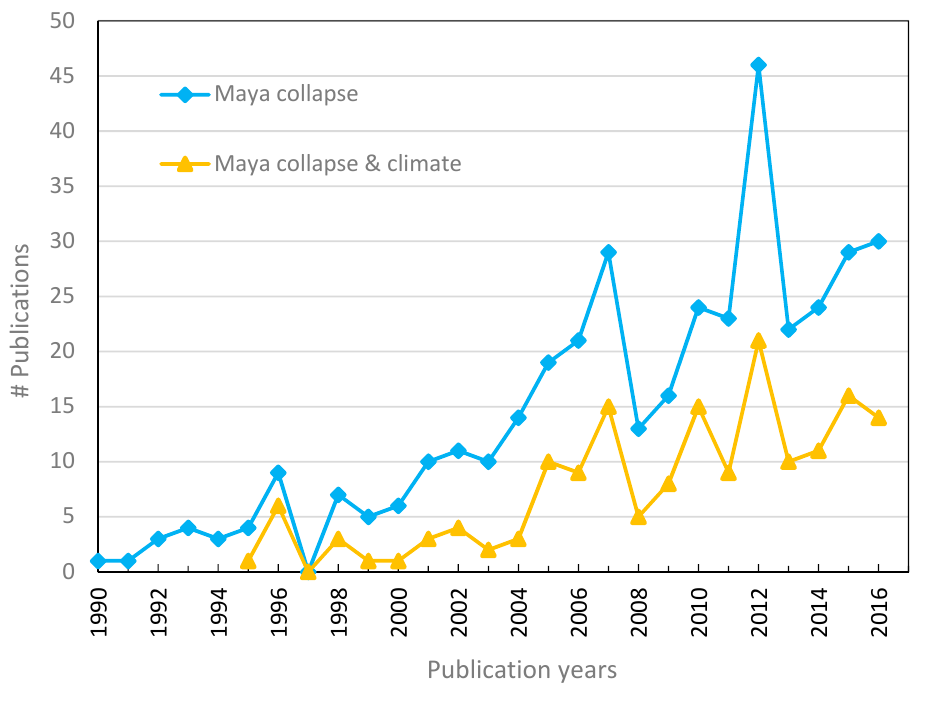
Figure 2. Number of publications per year related to the Maya collapse and to those in combination with climate. Source: WoS.